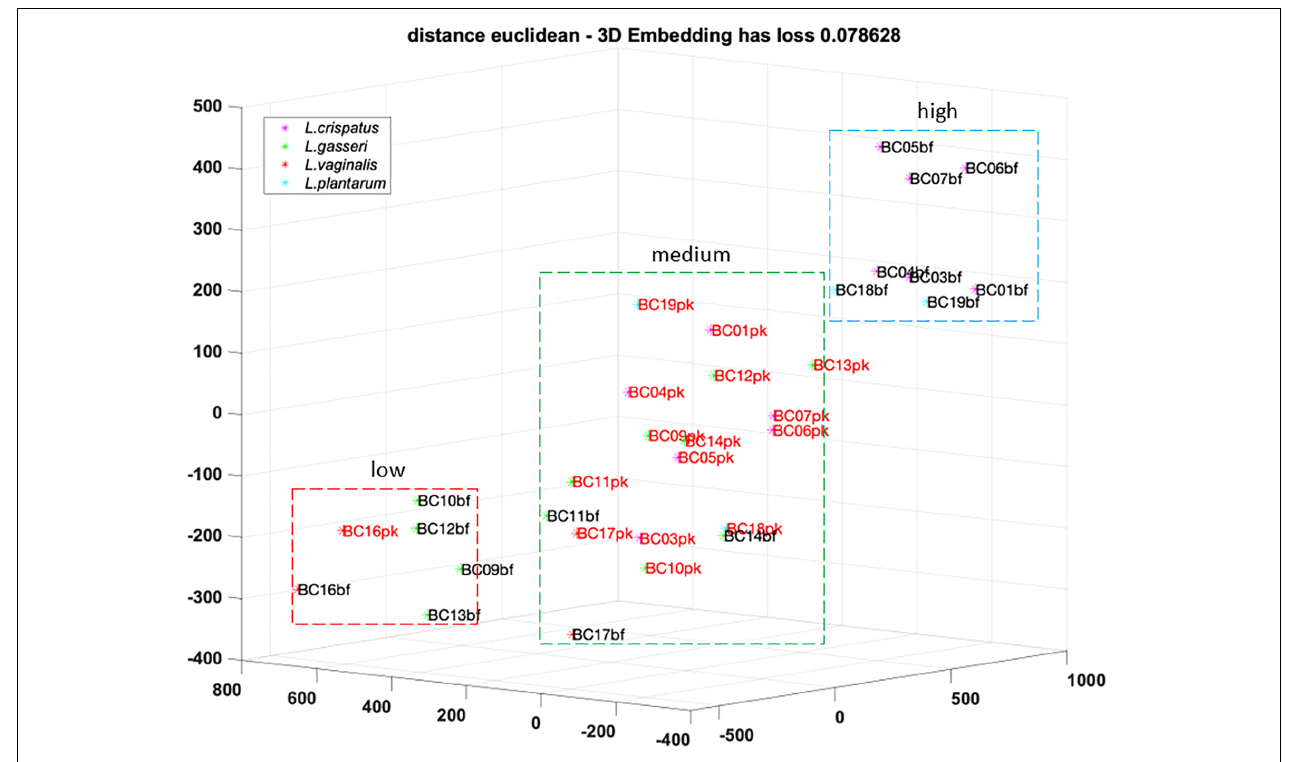
FIGURE 4 | t-SNE cluster analysis on CFS fungistatic activity dataset. Three groups were identified, corresponding to low, medium, and high activity. Samples derived from biofilm and planktonic cultures were signed in black and red, respectively.